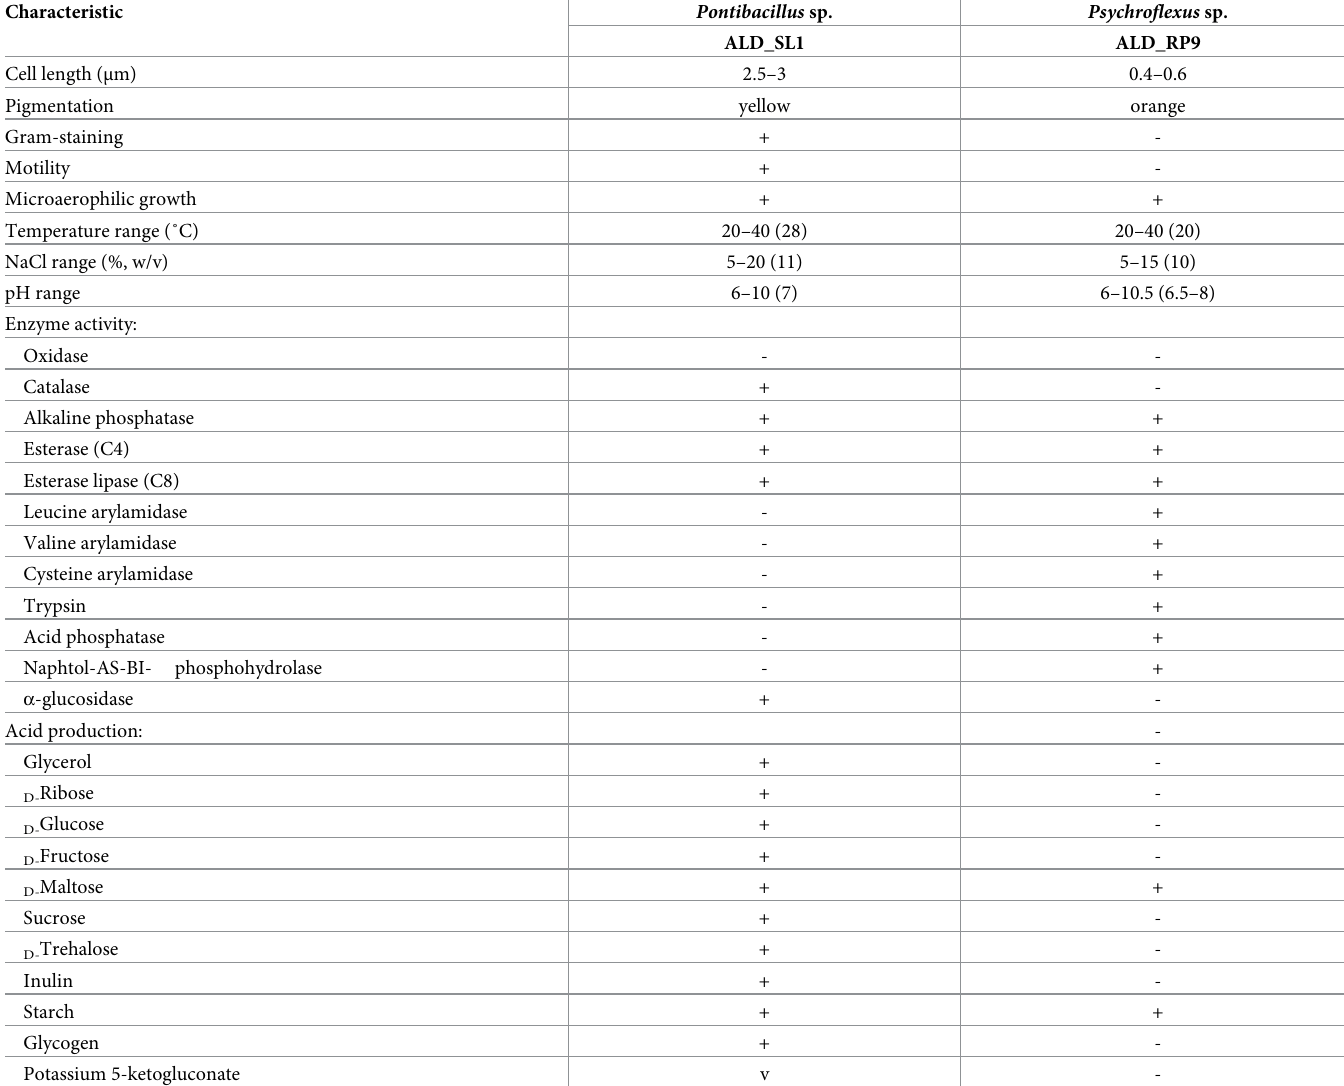
Table 1. Morphological, growth and enzymatic characteristics of Pontibacillus sp. ALD_SL1 and Psychroflexus sp. ALD_RP9. Characteristic